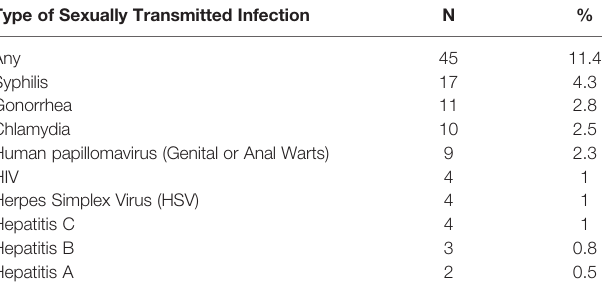
TABLE 2 | Frequency of sexually transmitted infections among gay and bisexual male prostate cancer survivors since their prostate cancer treatment (N = 395). Type of Sexually Transmitted